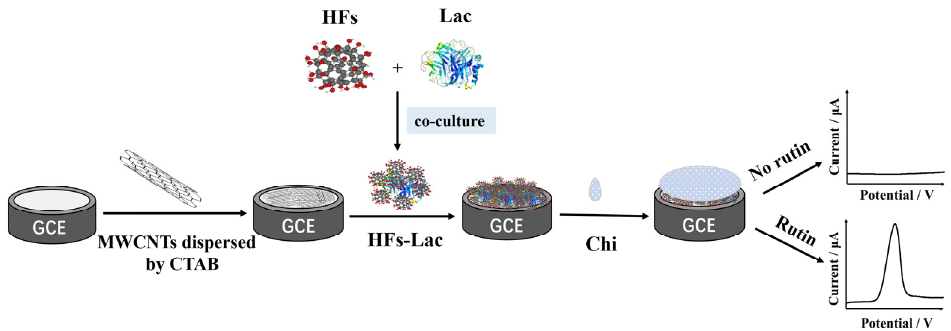
Figure 1. Preparation process of nanocomposite-modified GCE.